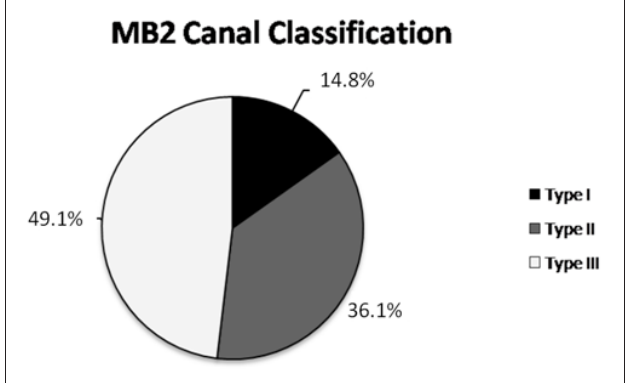
Fig. 2. Simplified classification of MB2 canals